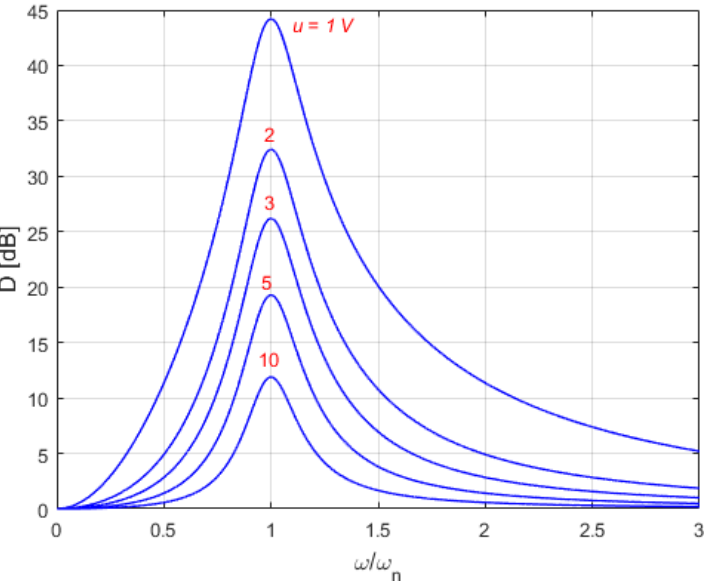
Figure 7. Damping efficiency index for different input voltages u of the damping valve at upstream pressure p A = 1 MPa.